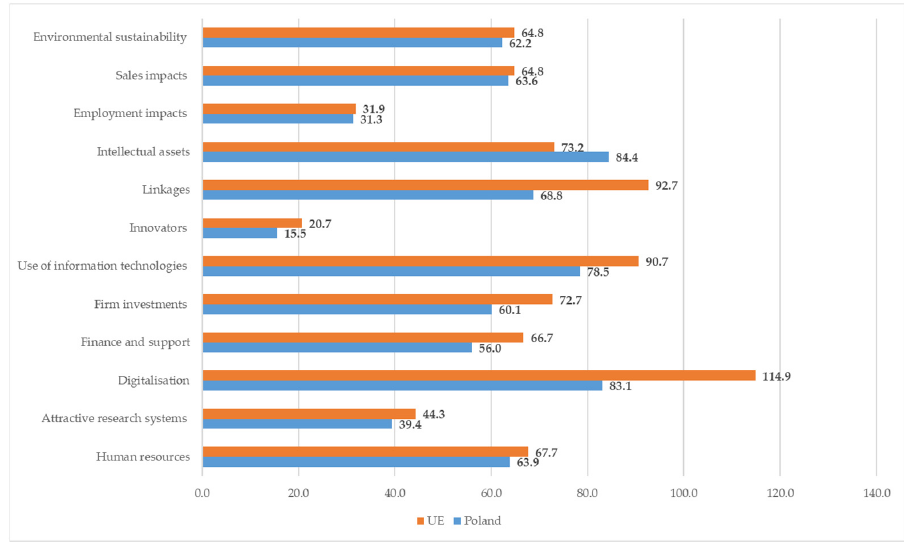
Figure 1. Poland’s ranking as compared with EU’s average using particular innovativeness assessment criteria in European Innovation Scoreboard, 2021.